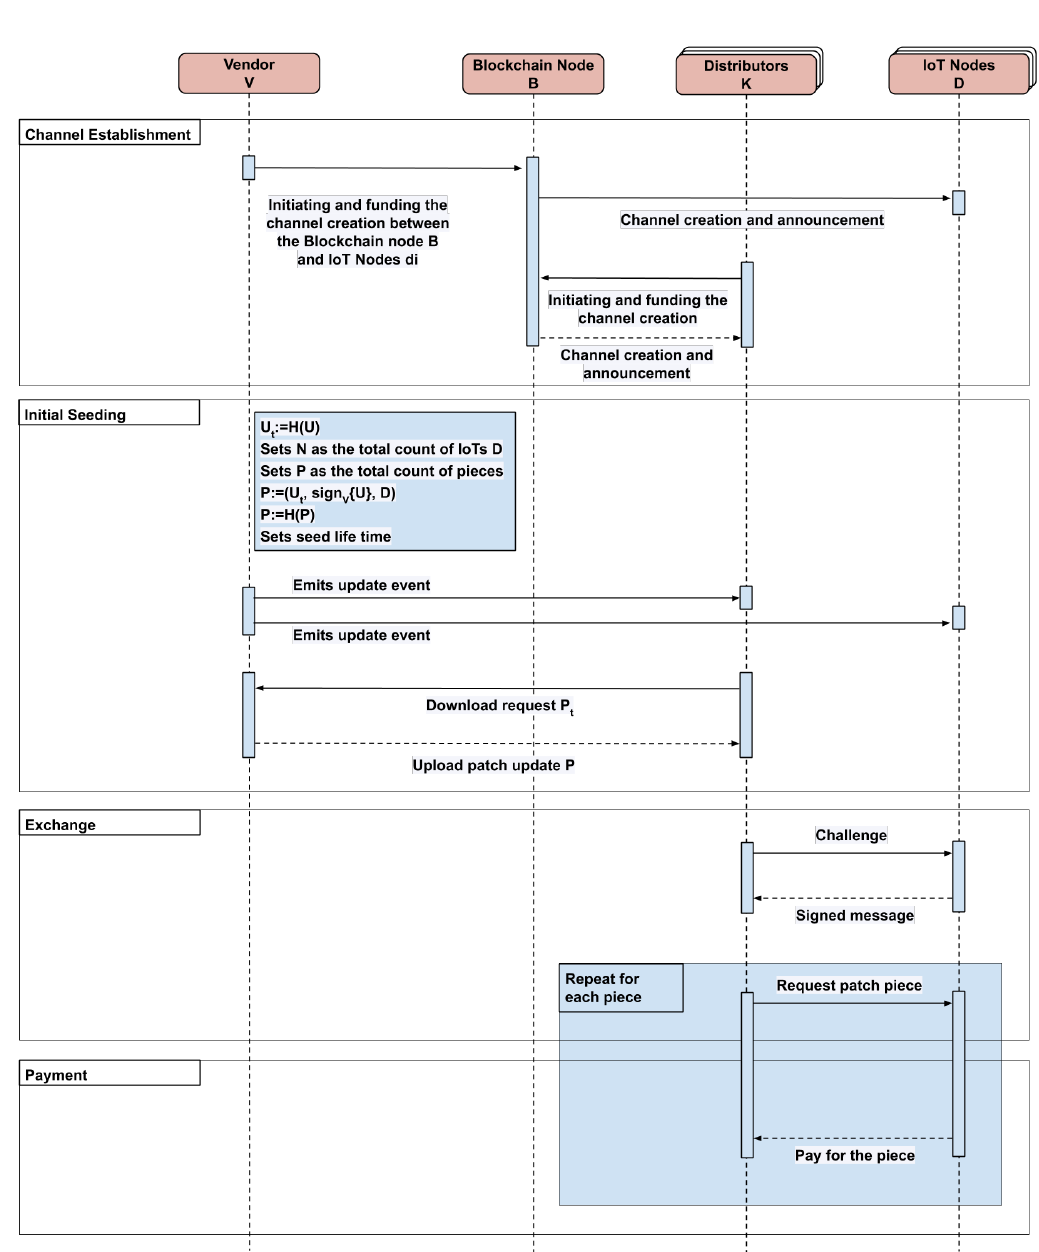
Figure 2. P 4 UIoT sequence